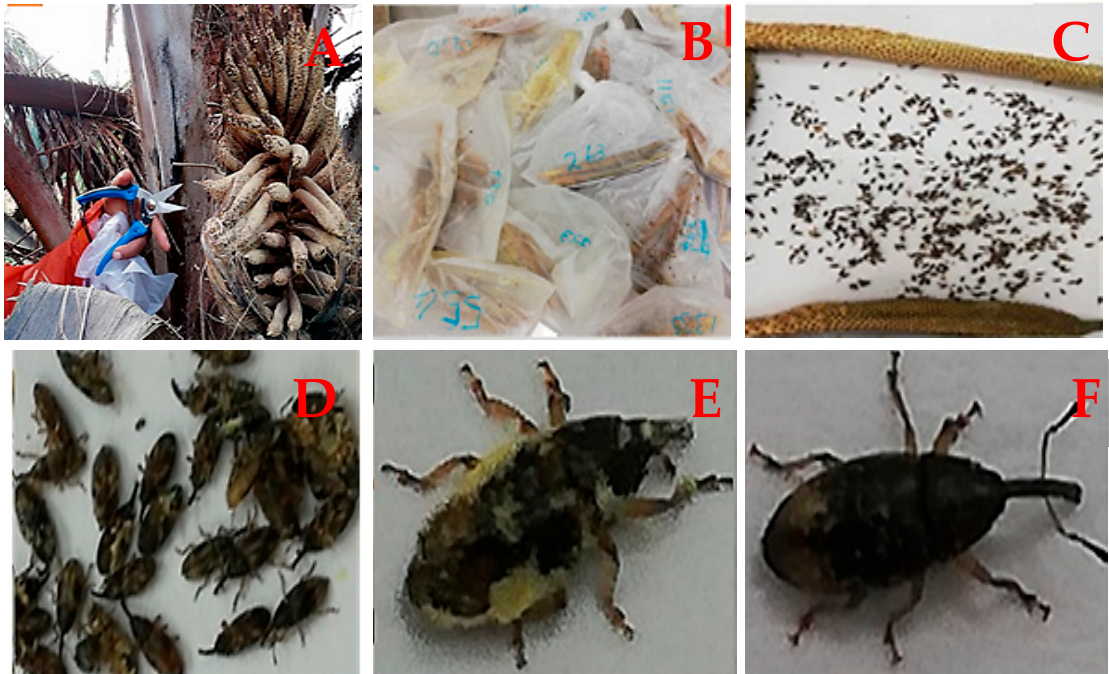
Figure 2. Collected samples of E. kamerunicus and determination of male and female: ( A ) harvesting of anthesising male inflorescence spikelets; ( B ) collected samples of E. kamerunicus ; ( C ) spikelets and pollinator weevils; ( D ) assorted male and female E. kamerunicus ; ( E ) male lateral view of E. kamerunicus ; ( F ) female lateral view of E. Kamerunicus.